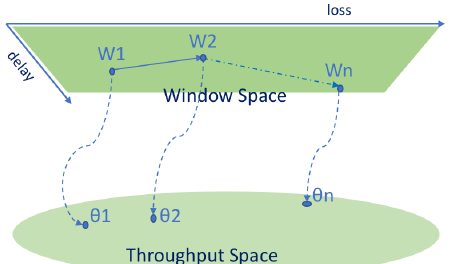
Figure 1. Primal dual mapping: illustrative representation of dual